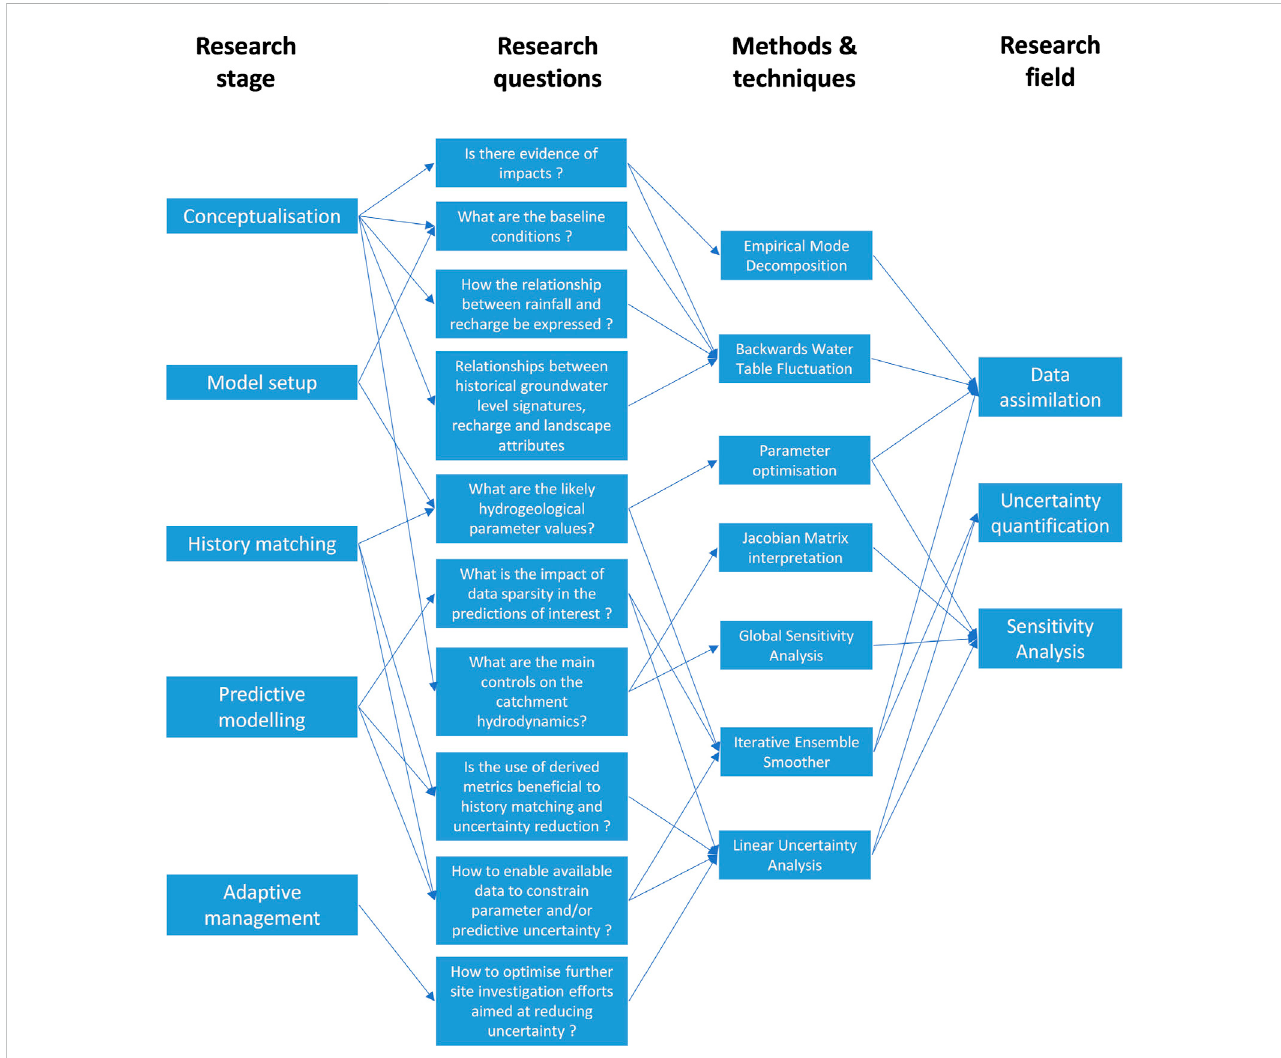
FIGURE 1 Example of DA, UQ and SA techniques, and their potential to support research in endorheic basins.